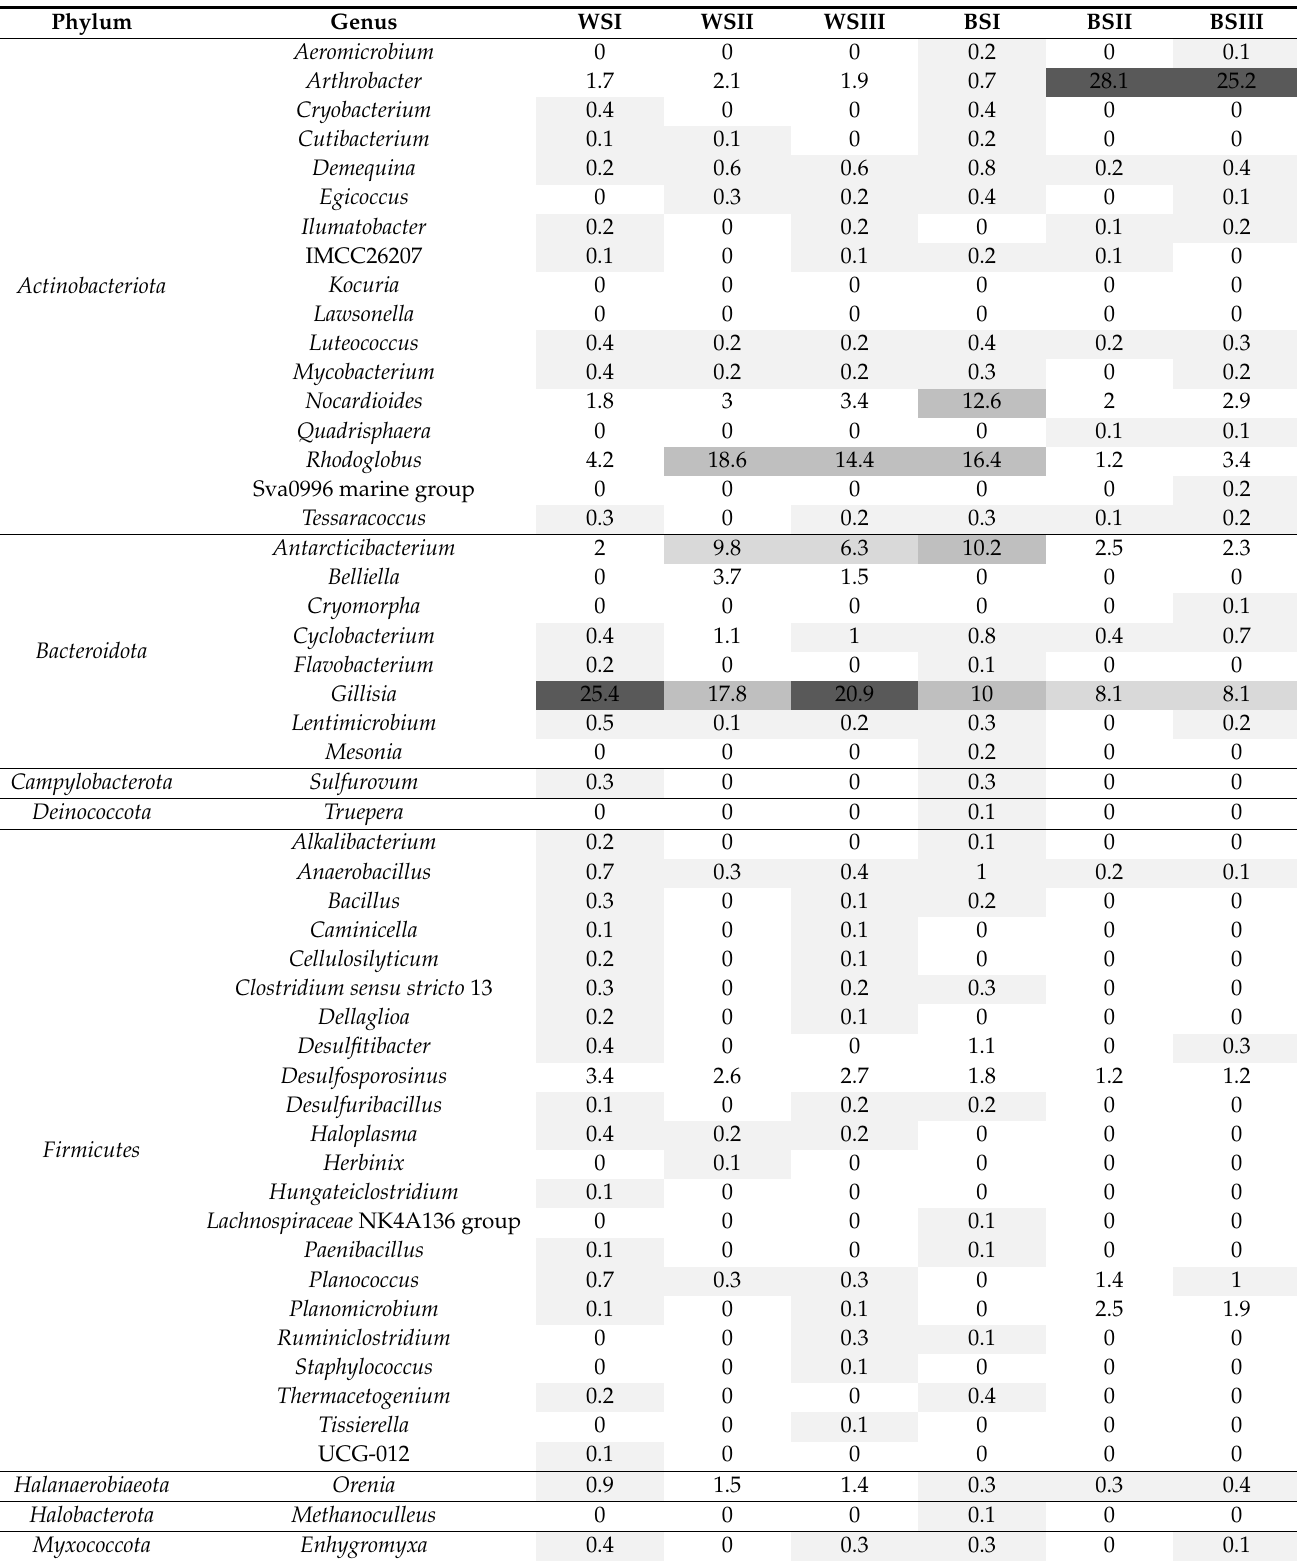
Table 1. Bacterial taxonomic group distribution at genus level (relative abundance ≥ 0.1%). WS , white salt; DS , dark